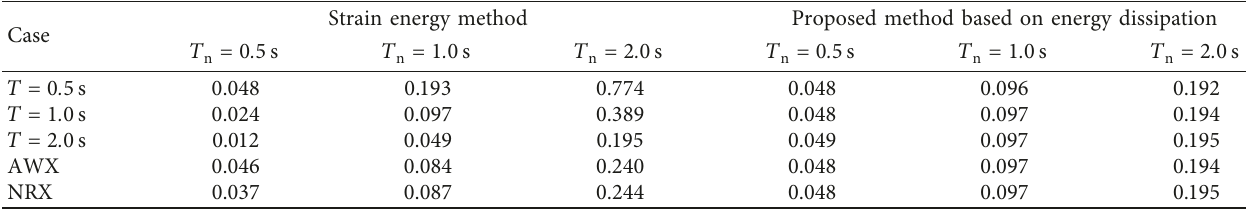
Figure 3: Cumulative energy dissipated by inherent damping and viscous damper and time histories of additional EDR of the SDOF system with the period equal to 1.0s (the lines of inherent damping and the damper denote the cumulative energy dissipated by inherent damping and damper, respectively). (a) Sine wave, T � 0 . 5s; (b) sine wave, T � 1 . 0s; (c) sine wave, T � 2 . 0s ; (d) AWX; (e) NRX. Table 2: Additional EDRs obtained by the strain energy method and proposed method for different